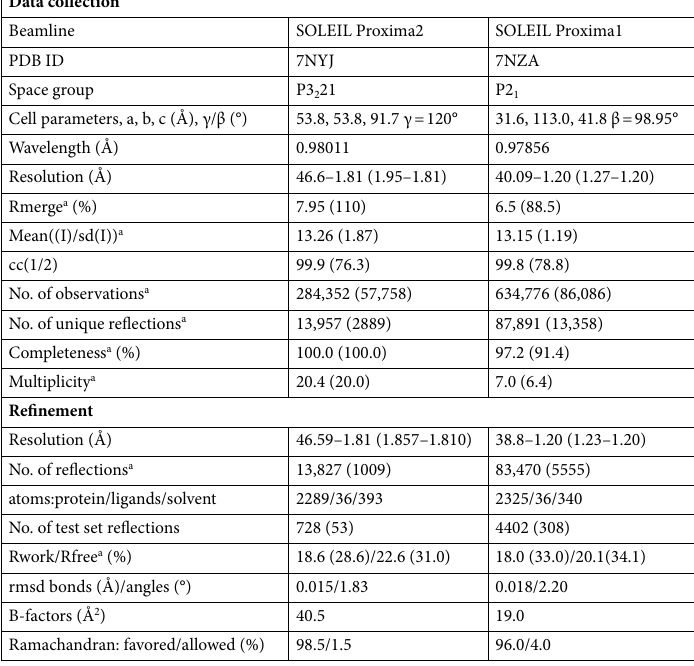
Table 1. Data collection and refinement statistics. a Refers to the highest-resolution